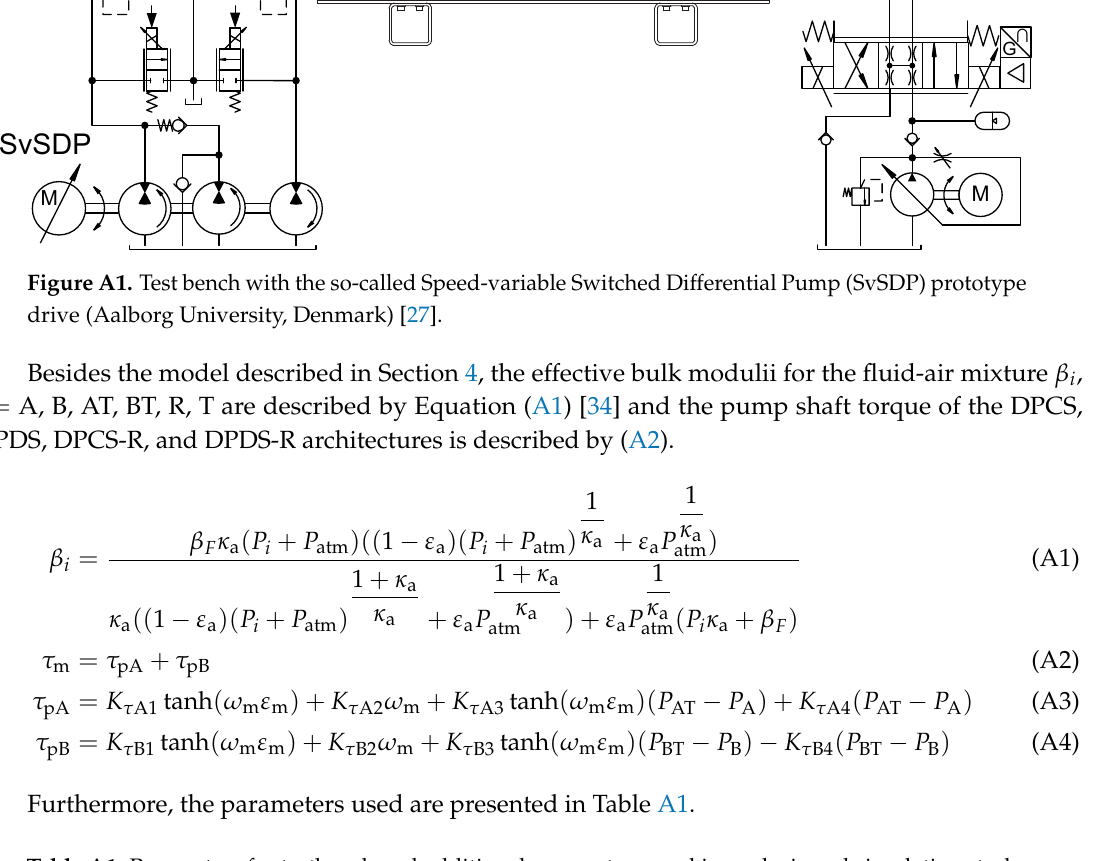
Table A1. Parameters for testbench and additional parameters used in analysis and simulation